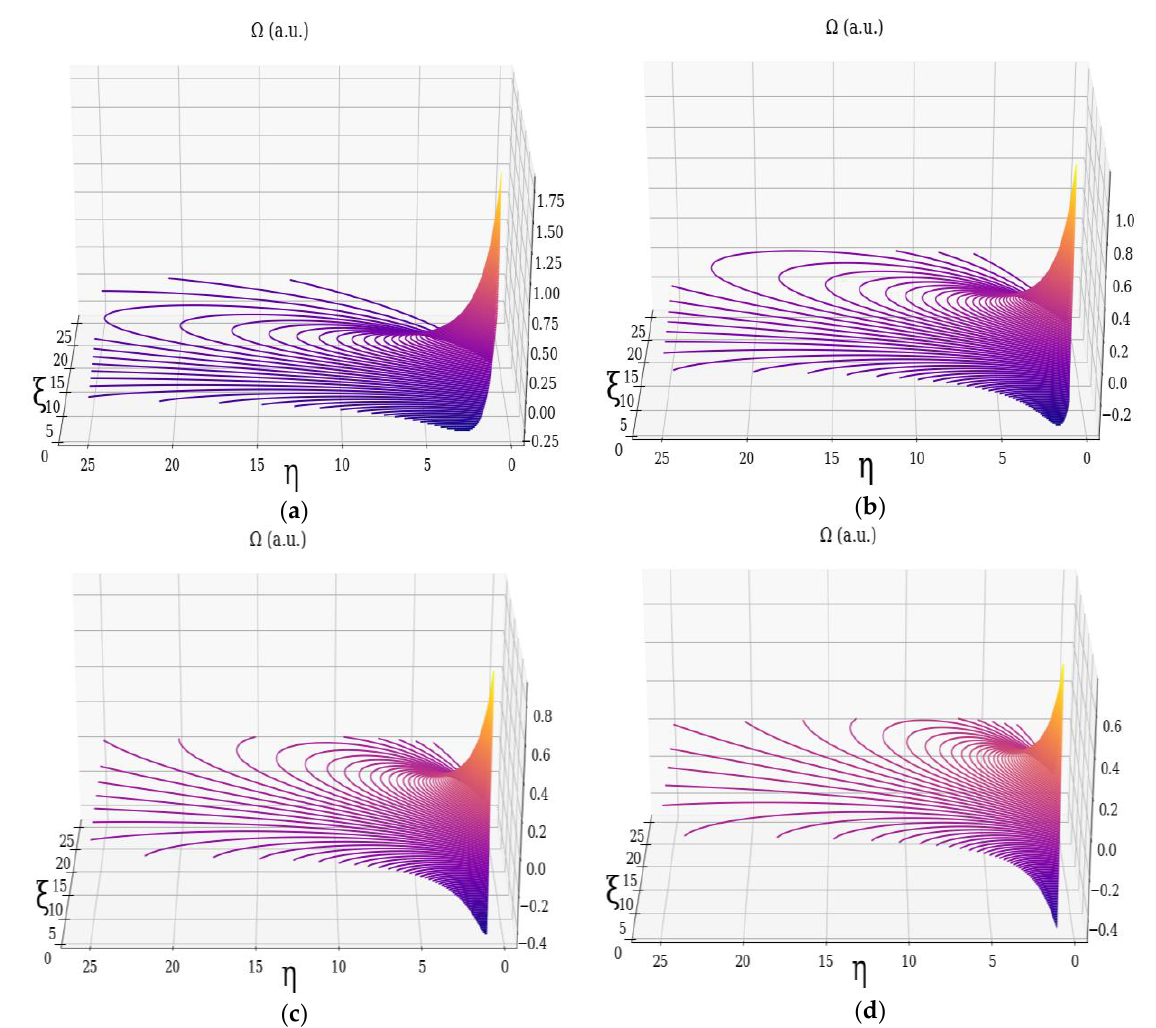
Figure 2. Dimensionless velocity field V of non-differentiable atmospheric multifractal: ( a ) ν = 0.5 , ( b ) ν = 1 , ( c ) ν = 1.5 , ( d ) ν = 2 .